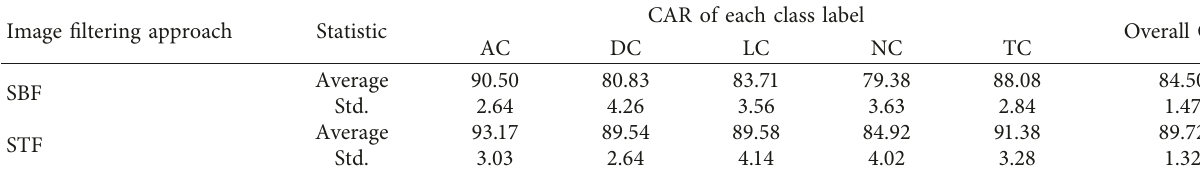
Table 1: Classification results of Adaboost CTree.